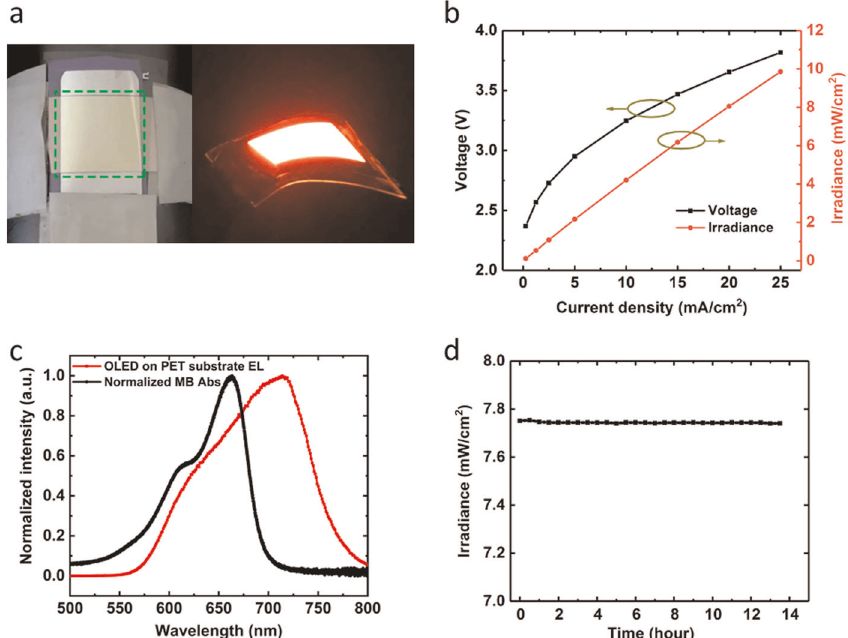
Fig. 2 Design and performance of 4-cm 2 fl exible OLEDs. a Photos of 4-cm 2 fl exible OLED. b V – J-irradiance characteristics of 4-cm 2 fl exible OLED. c Emission spectrum of 4-cm 2 fl exible OLED and absorption spectrum of methylene blue. d 4-cm 2 fl exible OLED driven at a constant current density of 25 mA/cm 2 for the operational lifetime